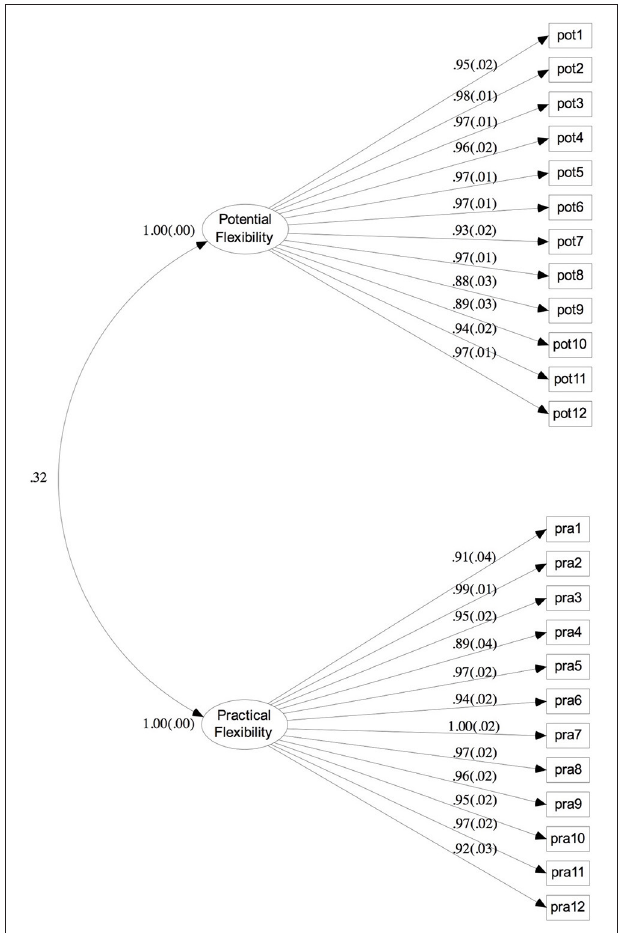
FIGURE 2 | Factor loading and factor intercorrelations for potential flexibility and practical flexibility. All estimated coefficients are significant with p < 0.001. Pot, Potential Flexibility Item; Pra, Practical Flexibility